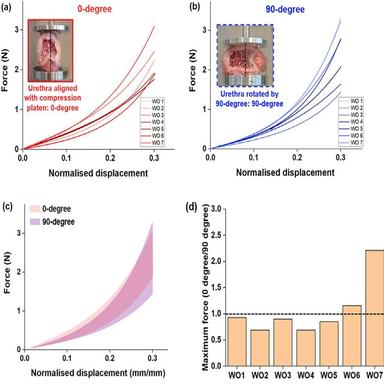
Compression testing performed on WO at 0-degree (urethra aligned to compression platen) (a) and 90-degree (urethra rotated by 90-degree) (b) orientation up to a deformation of 30 %. (c) The overlapping zones show a nearly isotropic mechanical behaviour of WO segments at 0- and 90-degree. (d) Maximum force (0°/90°) across all the seven WO specimens.